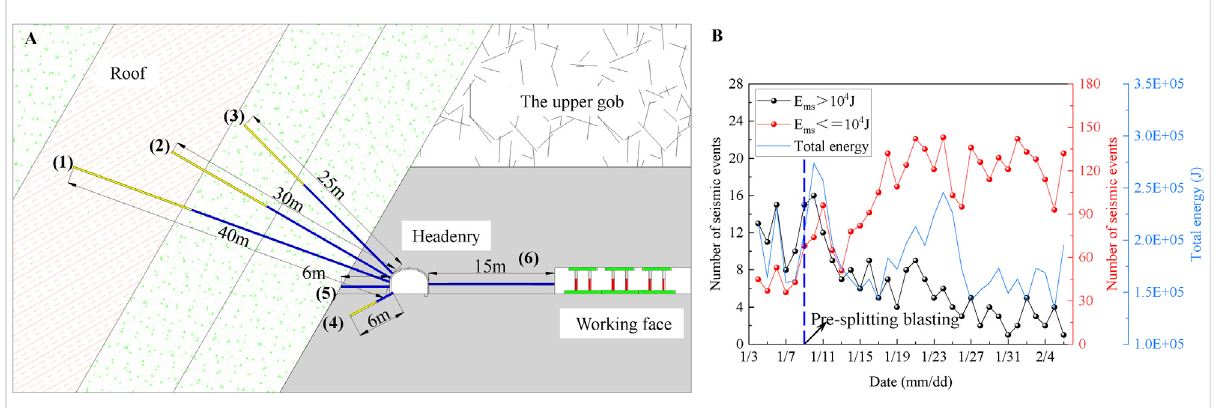
FIGURE 15 Prevention measures for MISTCB and monitoring results of the mining induced seismic events: (A) prevention measures for MISTCB, (B) monitoring results of the mining induced seismic events.